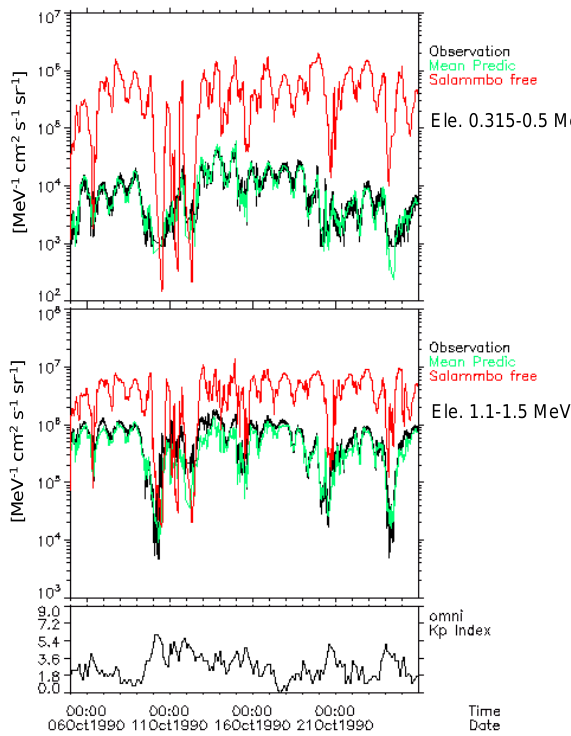
Fig. 12. Comparison of mean prediction of the ensemble Kalman filter where LANL-GEO and GPS ns18 data are assimilated, with measurements along GEO orbit, for 0.315–0.5MeV (top panel) and 1.1–1.5MeV (middle panel) electrons. Black curve is the observa- tion, green curve is the mean ensemble Kalman filter prediction and red curve is the pure Salammbˆo prediction. The magnetic activity index Kp is plotted in bottom